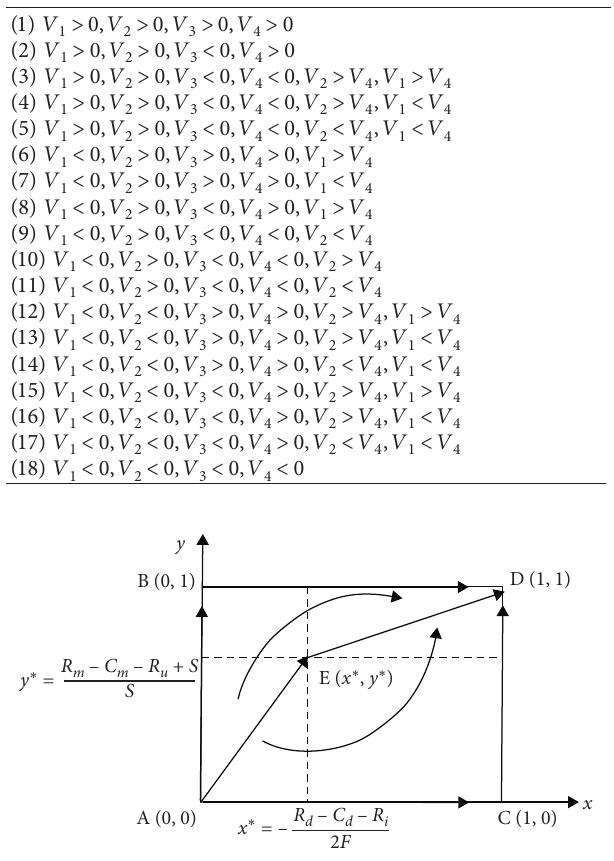
Table 5: Summary of different scenarios.